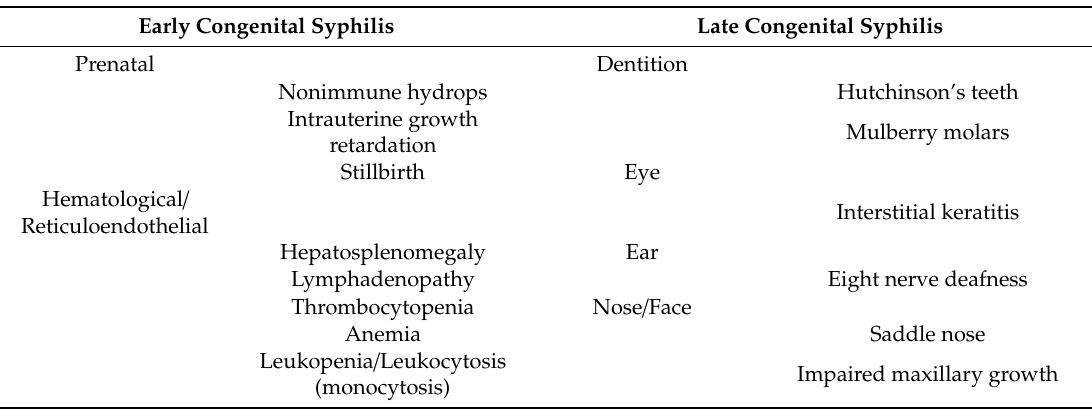
Table 1. Clinical manifestations of early and late congenital